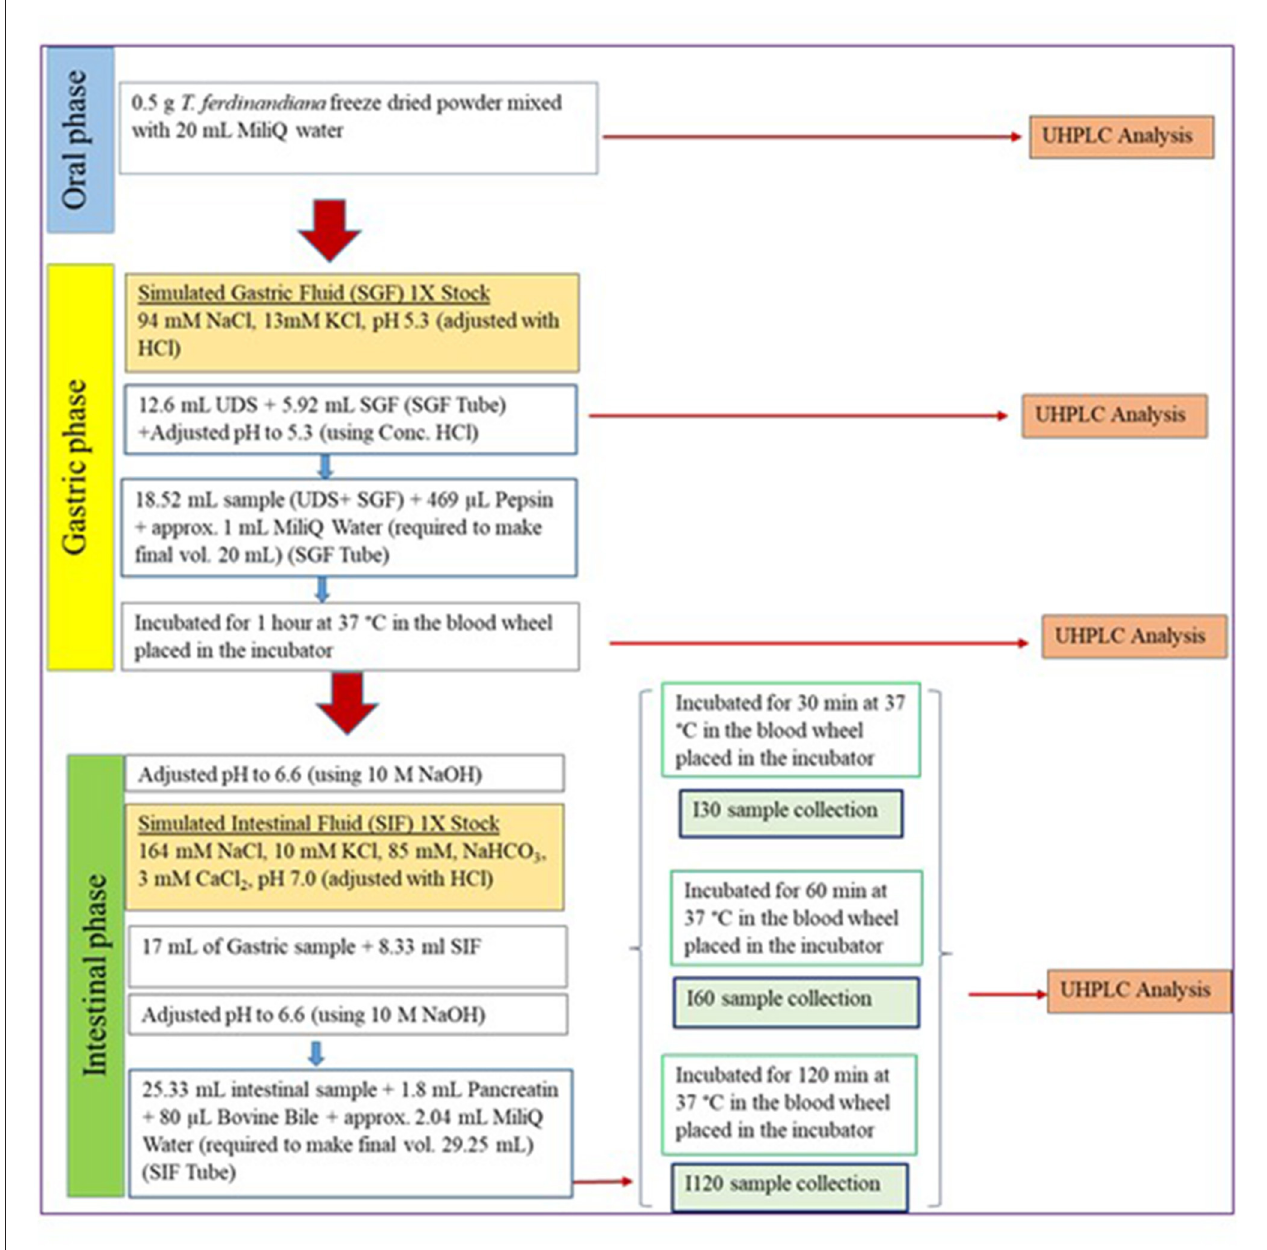
FIGURE 1 | Schematic flow chart of the applied in vitro digestion protocol (14). SGF, simulated gastric fluid; UDS, undigested samples; SIF, simulated intestinal